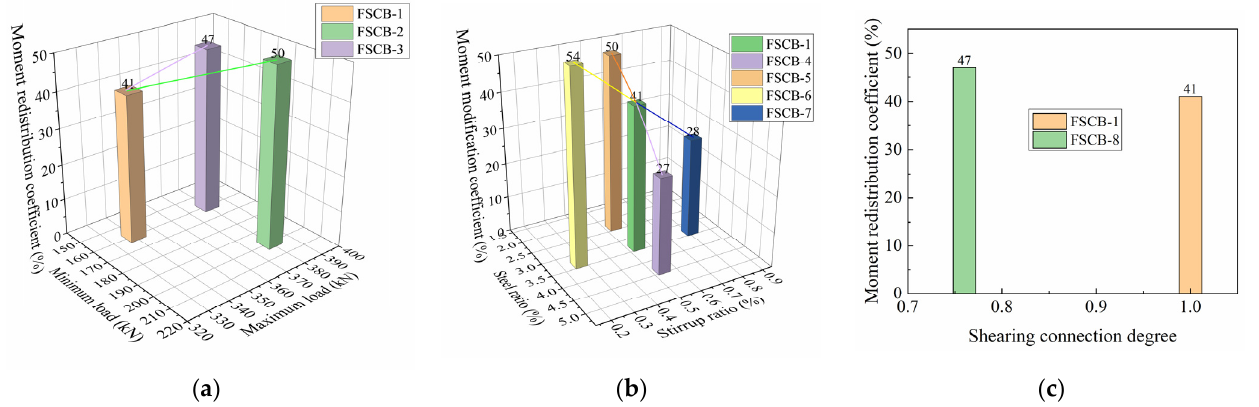
Figure 16. The di ff erences in the moment modi fi cation coe ffi cient among specimens: ( a ) relation of moment modi fi cation coe ffi cient vs. fatigue load amplitude; ( b ) relation of moment modi fi cation moment modification coefficient vs. fatigue load amplitude; ( b ) relation of moment modification coe ffi cient vs. reinforcement ratio and stirrup ratio; ( c ) relation of moment modi fi cation coe ffi cient coefficient vs. reinforcement ratio and stirrup ratio; ( c ) relation of moment modification coefficient vs. vs. shear connection degree. shear connection